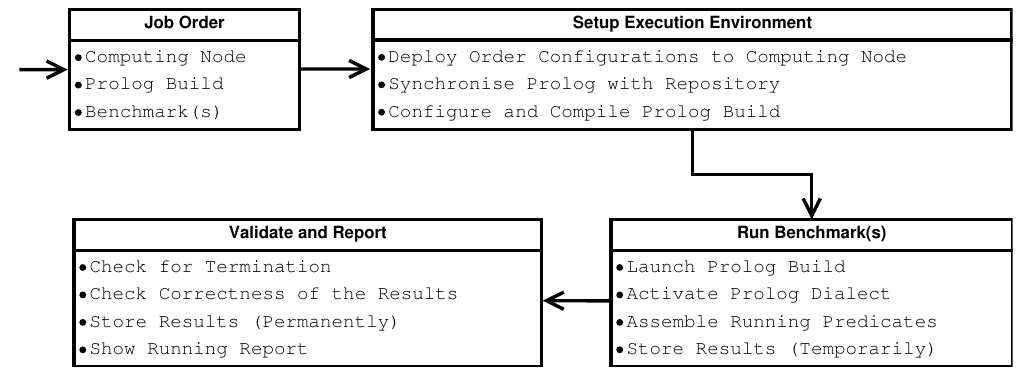
Figure 7. Pipeline of a job request to test the correctness of a Prolog system